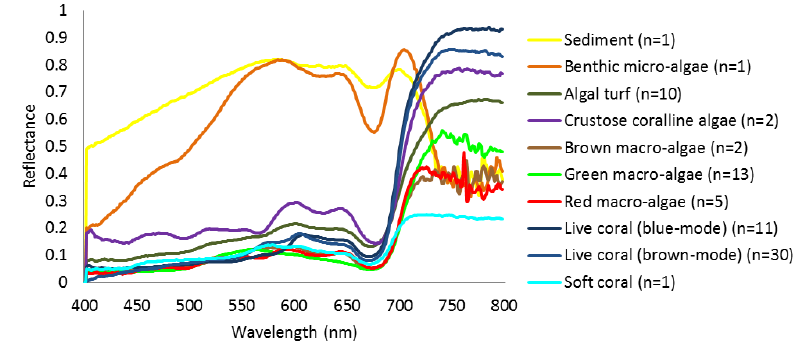
Figure 2. Mean spectral reflectance signatures measured in-situ at Heron Reef, and used as the bottom boundary layer in HydroLight